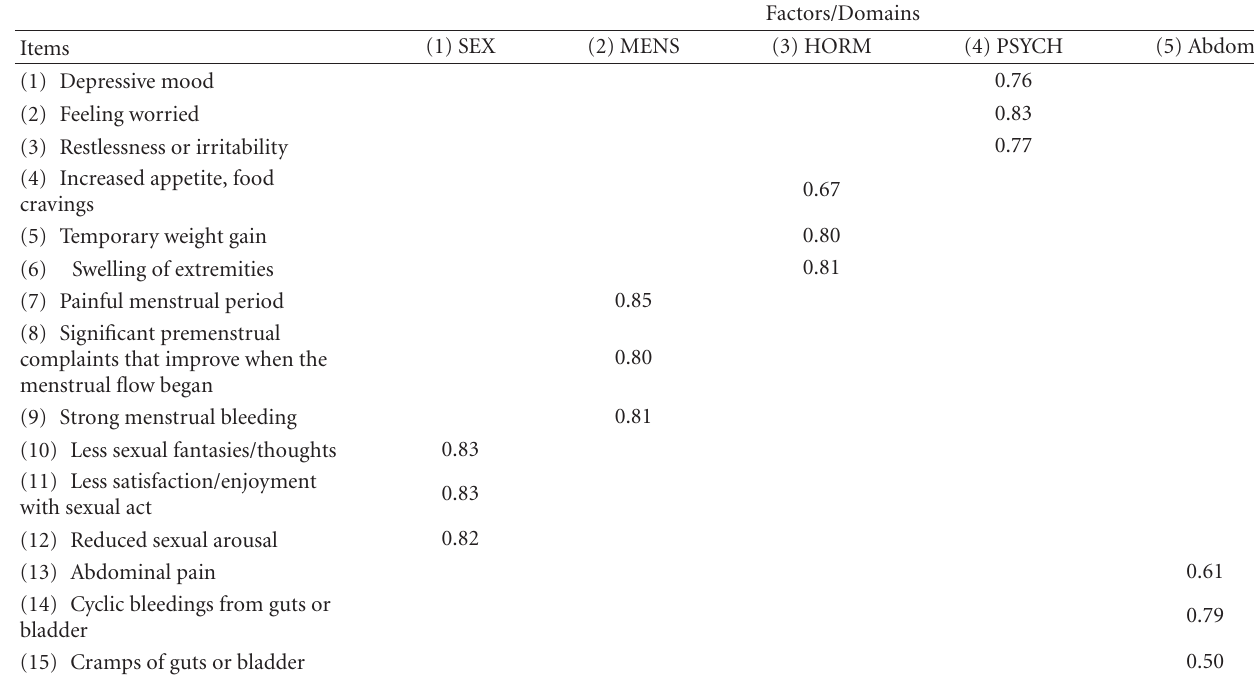
Table 2: Internal structure of the “Short-term Hormonal E ff ects (SHEs)” scale (factorial analysis; Italian normative survey; n = 228). The analysis determined five domains (explaining 66.1% of the total variance). The numbers in the table are factor loadings. Only loadings over 0.5 are